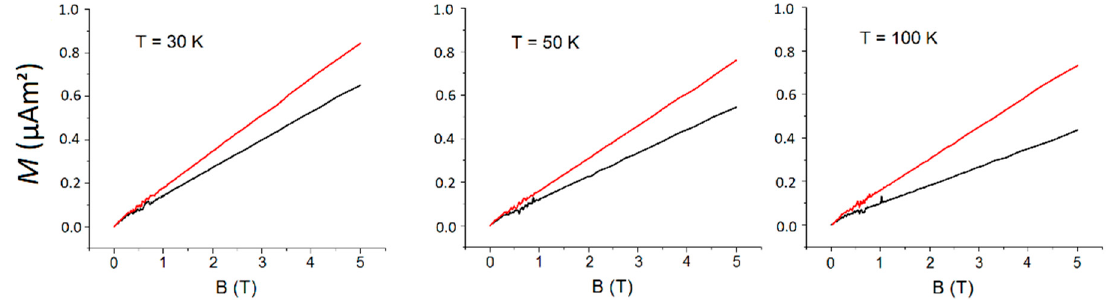
Figure 9. The measured virgin curves of [Ni(HL ox ) 2 ] on a SrTiO 3 disk. The red curves correlate to the measurements done under irradiation in the NIR region, and the black curves resemble the measurements done without irradiation.